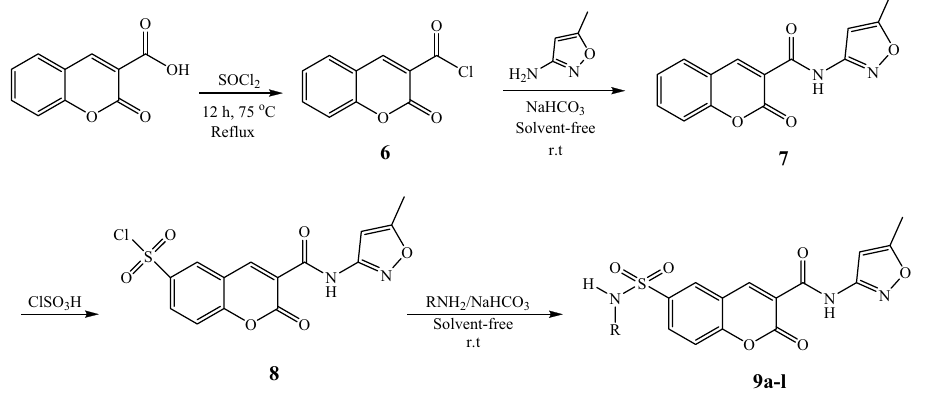
Figure 7. Synthetic route of the synthesis of coumarin sulfonamide isoxazol hybrids 9a – l